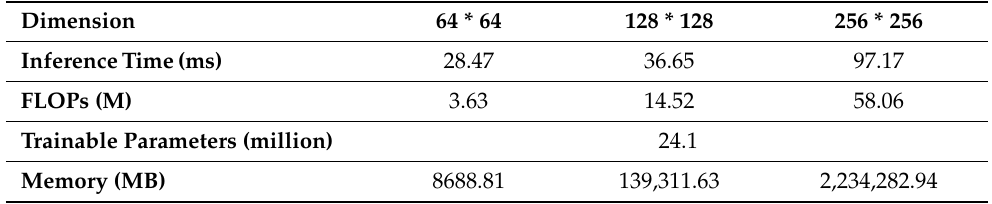
Table 4. Analysis of the proposed network developed as an end-to-end fully convolutional neural network.